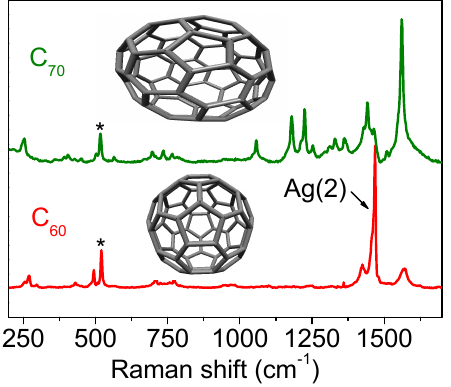
Figure 14. Raman spectra obtained from fullerenes C 60 and C 70 . The band at 520 cm − 1 and marked by a star is due to the underlying silicon wafer. λ 0 = 514 nm.